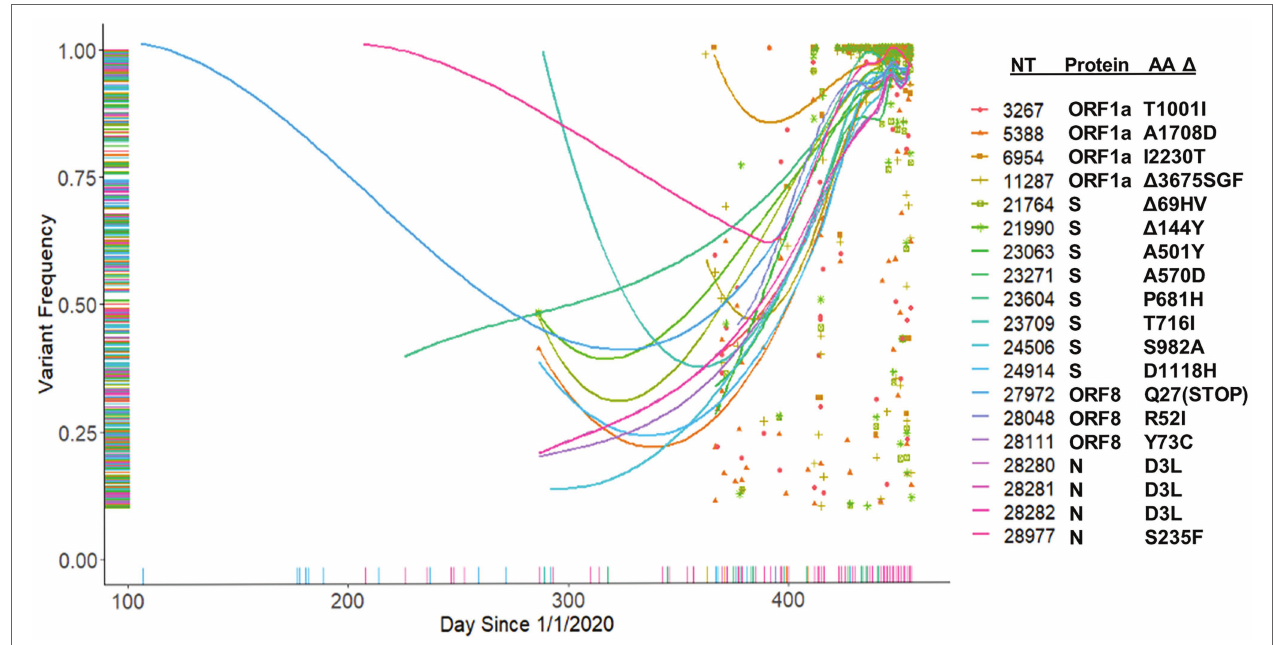
FIGURE 10 | Tracking of B.1.1.7 mutations. Frequency of B.1.1.7 variants identified in the patient samples beginning from January 1, 2020.